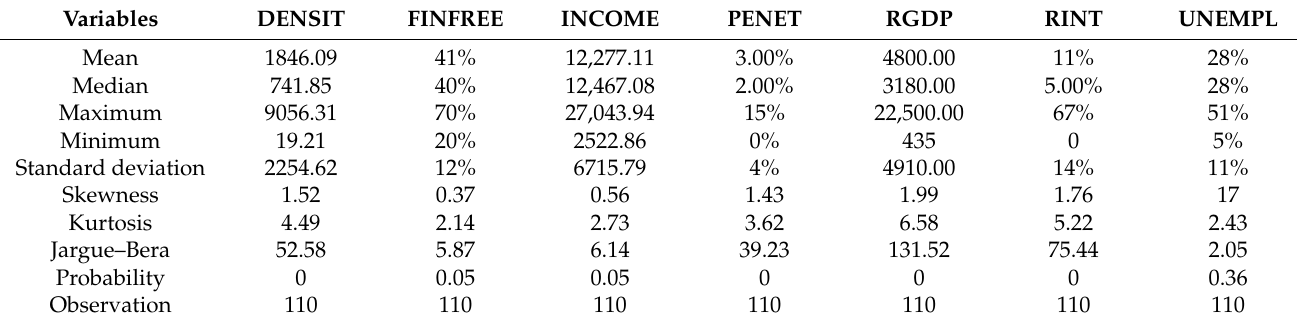
Table 3. Summary